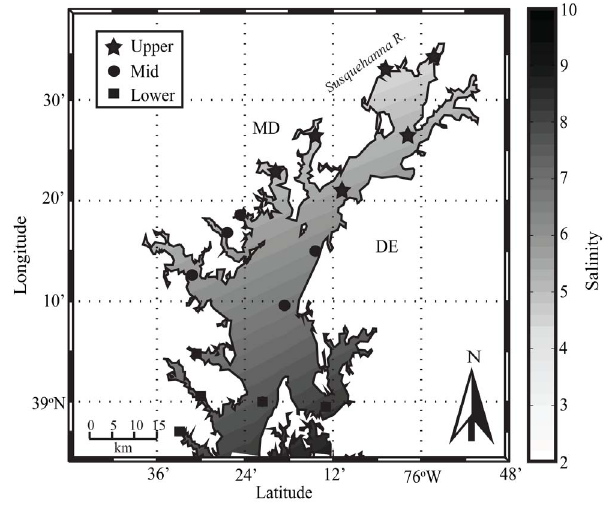
Figure 1. Map of the study area, showing contours of average surface water salinity. Dark markers represent in situ monitoring stations used for each of the subregions in this study: upper (star), mid (circle), and lower (square).